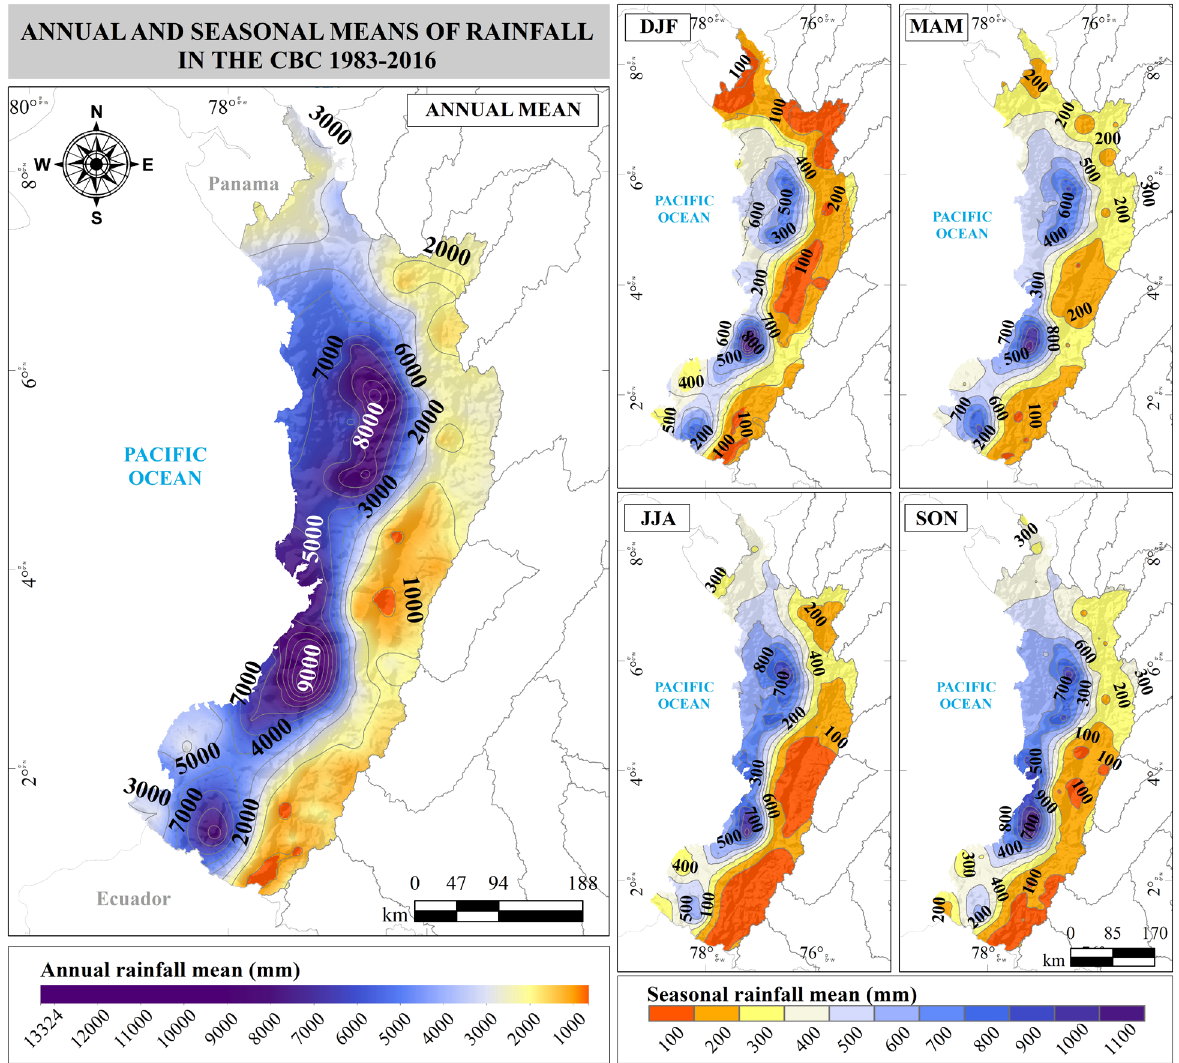
Figure 3. Annual and seasonal means rainfall in the Colombian Biogeographic Choco (CBC) for the 1983-2016